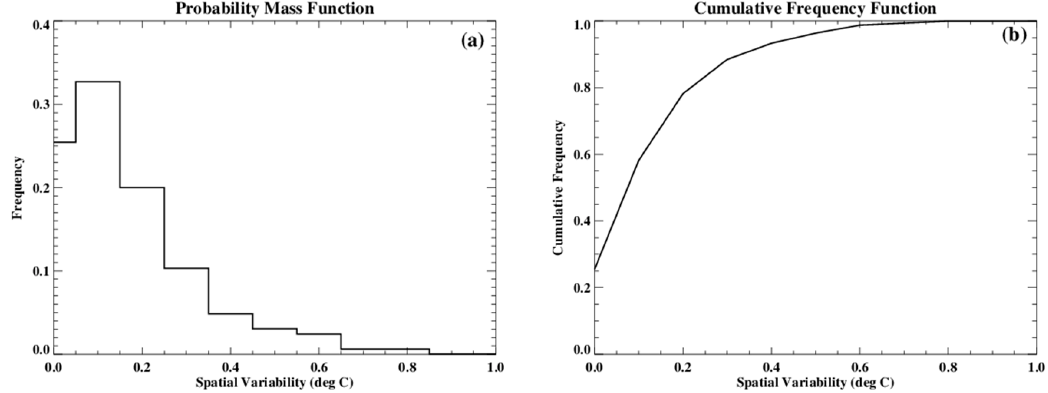
Figure 4. Probability mass function ( a ) and cumulative density function (CDF, ( b ) for the standard deviations of the BESST measurements within the MODIS Maximum Value Composite (MVC) SST pixels.